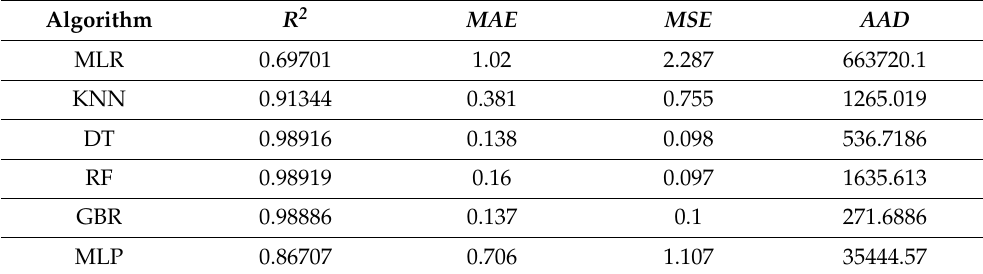
Table 1. Accuracy metrics and comparison of 6 ML algorithms for the ionic liquids’ dataset. Algorithm